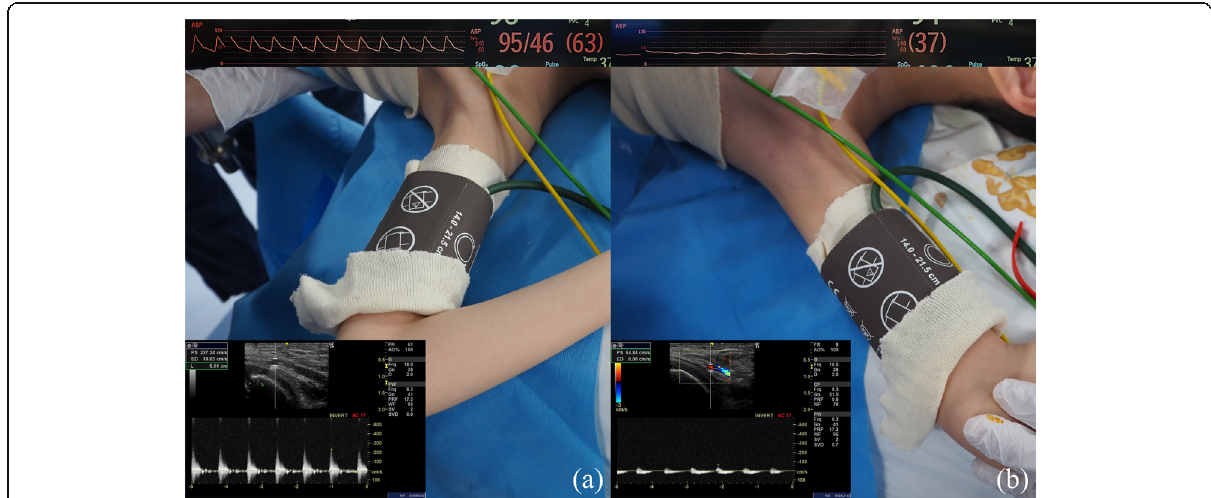
Fig. 1 Change in the radial and axillary arterial flow. a Slightly abducted position: the pressure waveform of the radial artery and Doppler signal of the axillary artery exist. b Excessive abducted position with external rotation: the pressure waveform of the radial artery and Doppler signal of the axillary artery have